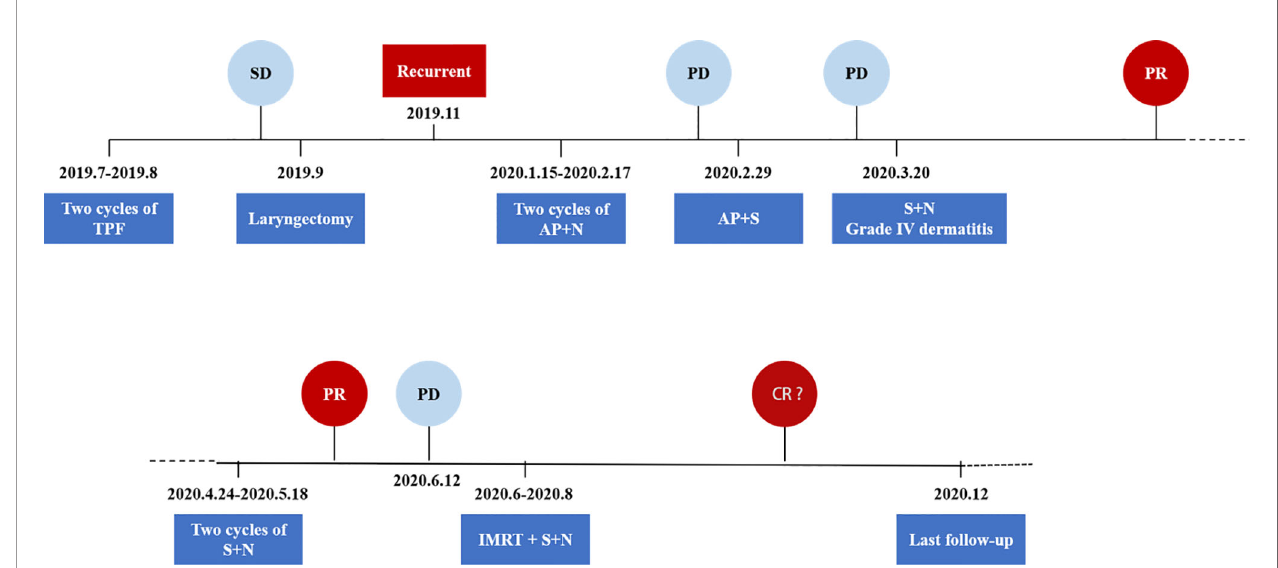
FIGURE 4 | Schematics and timeline of treatment. AP, albumin paclitaxel; CR, complete response; N, nimotuzumab; PD, progressive disease; PR, partial response; S, sintilimab; SD, stable disease; TPF, docetaxel, cisplatin, and 5- fl